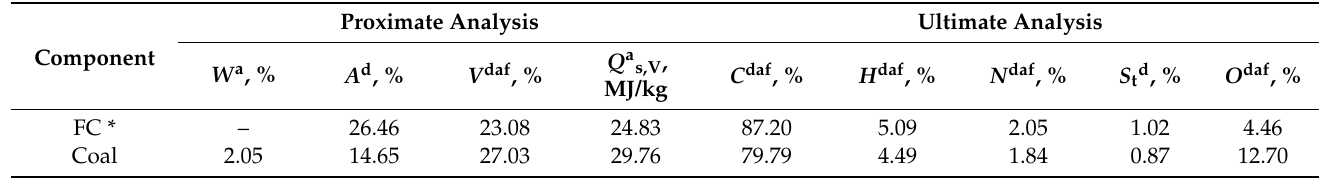
Table 2. Characteristics of coal and FC.